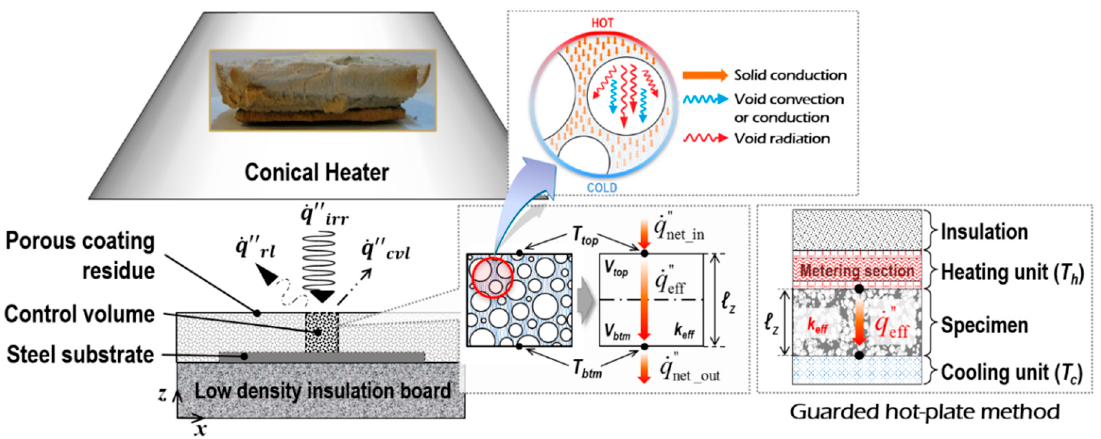
Figure 7. Heat transfer mechanism through the porous specimen in cone calorimeter testing.